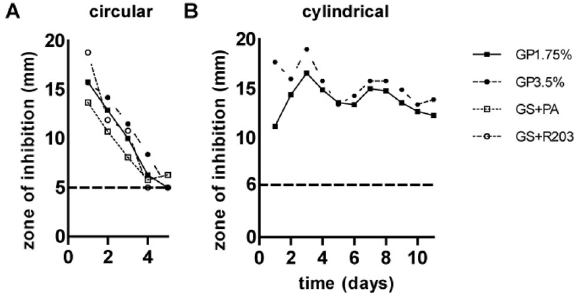
Fig. 3 Zones of inhibition against SA using circular and cylindrical samples of gentamicin-coated ePTFE grafts. A circular coated samples with GP1.75%, GP3.5%, GS + PA and GS + R203. B cylindrical sam- ples of gentamicin-coated ePTFE grafts with GP1.75% and GP3.5%